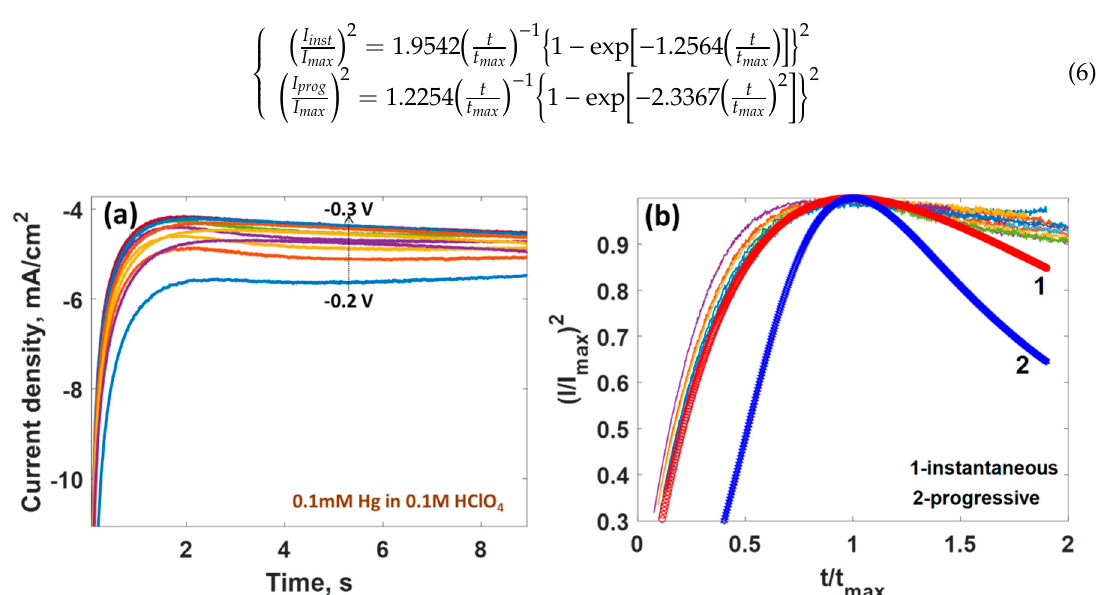
Figure 4. ( a ) Potentiostatic current transients for the electrodeposition of mercury onto the epitaxial graphene electrode from in 0.1 M HClO 4 + 0.1 mM Hg 2+ recorded at the cathodic potential pulses of different amplitudes (from blue-colored curve at − 0.2 V to dark red-colored curve − 0.3 V). ( b ) Comparison of the dimensionless experimental current–time transients for the electrodeposition on mercury onto epitaxial graphene electrode with the theoretical transients for instantaneous (bold solid red curve 1) and progressive (bold solid blue curve 2) nucleation.